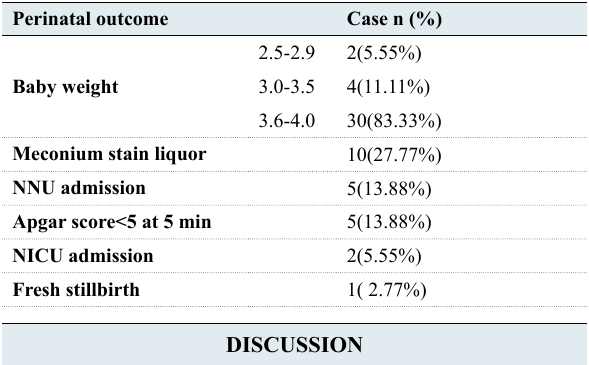
Table 1: Perinatal outcome among patients undergoing LSCS in the second stage of